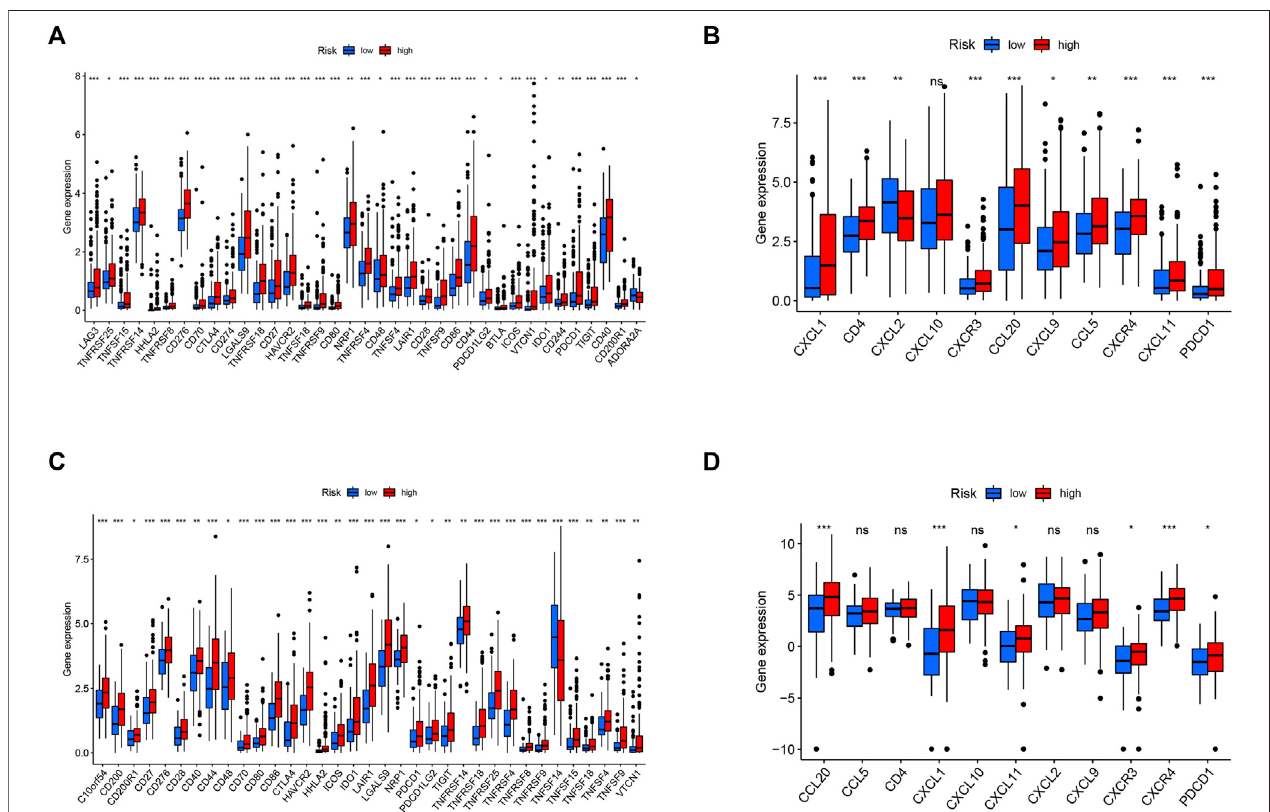
FIGURE 9 | Correlation between the risk score, immune checkpoints, and TIP-related genes. Expression of immune checkpoints between two risk subgroups in the TCGA cohort (A) and ICGC cohort (C) . The expression of TIP-related genes between high- and low-risk groups in the TCGA cohort (B) and ICGC cohort (D) . Adjusted p values were shown as *, p < 0.05; **, p < 0.01; and ***, p <